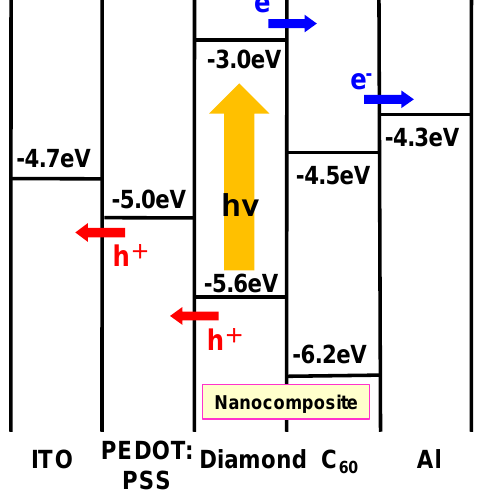
bulk heterojunction solar 60